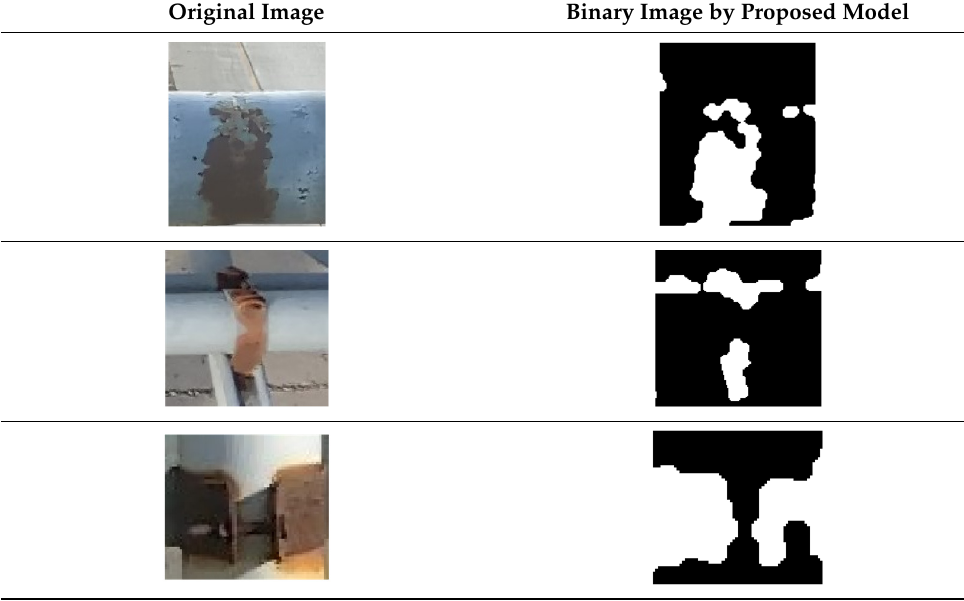
Table 9. Robustness evaluation of proposed model on external images.